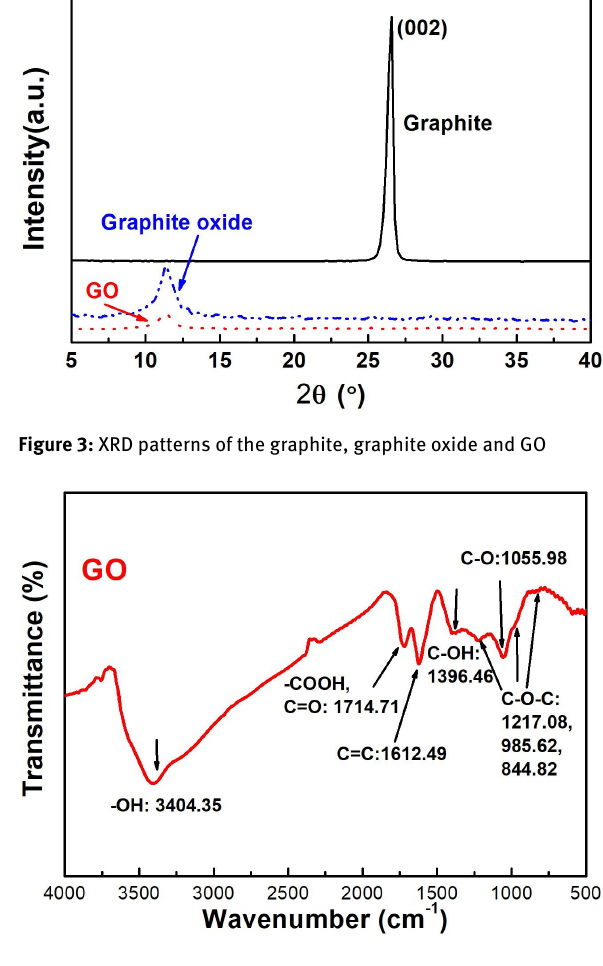
Figure 4: FTIR spectra of